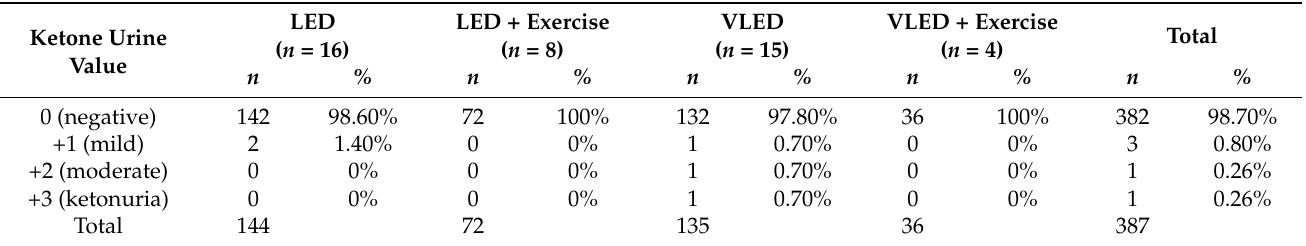
Table 6. Cumulative urine ketone results based on the dipstick test during the total intervention duration, in each arm. Ketone